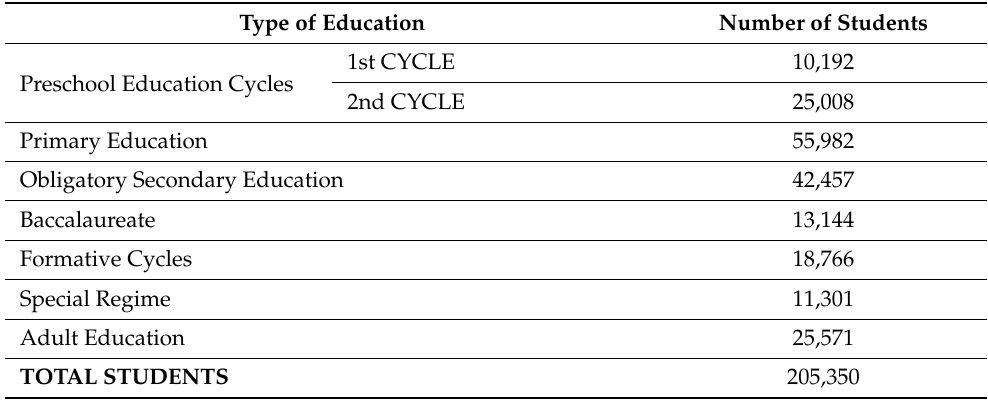
Table 1. Distribution of students in 2020–2021 school year, Granada province (prepared by the authors).